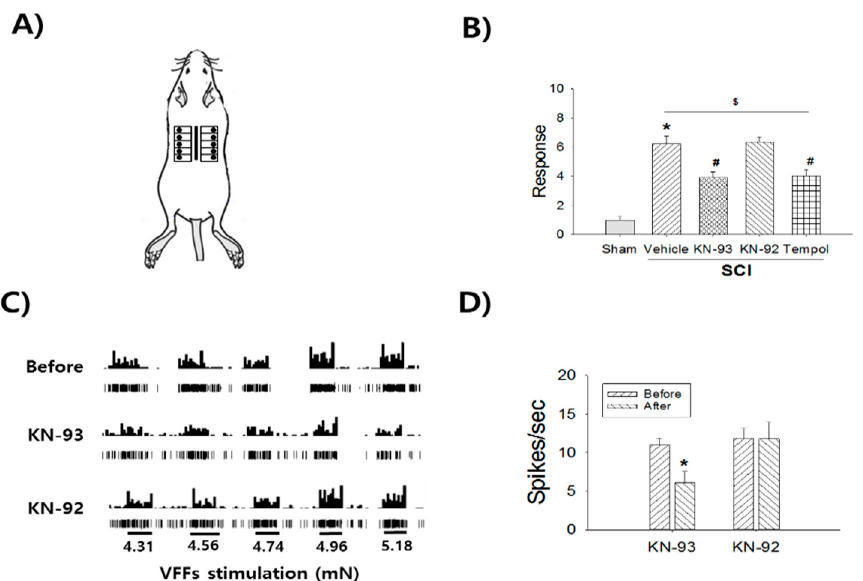
Figure 4. The contribution of pCamKII on mechanical sensitivity in the dorsal body trunk after SCI. ( A ) Dorsal trunks were divided by 10 square grids and 5.88 mN VFF was applied for 2 seconds at each square. Vertical bar: the incision of the back for the SCI surgery. Black circles: VFF stimulation dermatomes. ( B ) SCI (vehicle group) shows a significant increase of mechanical sensitivity compared to the sham group (* p < 0.05). However, KN-93 (50 µ g/10 µ L/kg) and Tempol (1 mg) treatments show significant decreases ( # p < 0.05), whereas KN-92 (50 µ g/10 µ L/kg) shows no significant changes compared to the vehicle group. However, all SCI groups show significant increases of mechanical sensitivity compared to the sham group ( $ p < 0.05). ( C ) Histograms (upper) and waveforms (bottom) represent the changes of WDR neuronal firing rates. ( D ) KN-93 treatment shows significant decrease of neuronal firing rates at 30 min compared to the before treatment (* p <